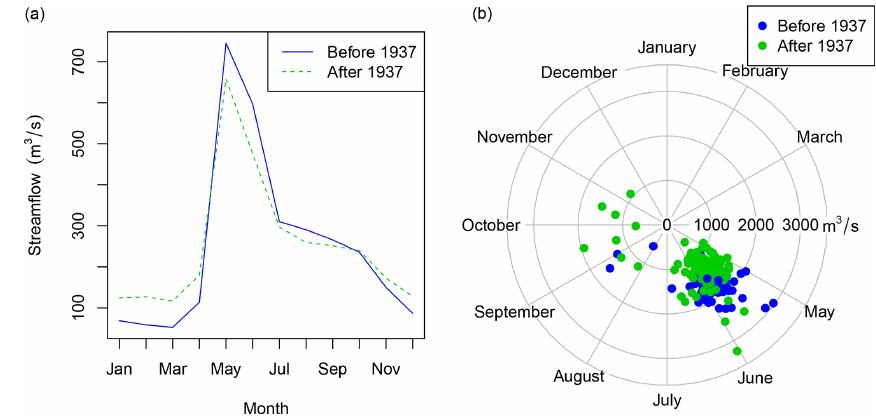
Figure 2. Seasonality of Glomma’s monthly streamflow (a) and annual maximum floods (b) at Elverum. The dampening of floods after 1937 is explained by upstream dam building.